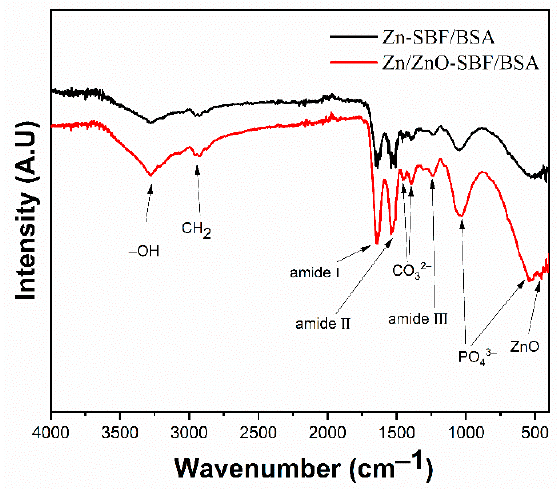
Figure 8. FTIR spectra of Zn and Zn/ZnO after 21 days immersion in SBF/BSA. Additionally, XPS was carried out for further insights on the chemical composition of the surface. Figure 9 depicts the XPS survey spectra for both bare Zn and Zn/ZnO samples in SBF/BSA after 21 days of immersion. Only signals of C, N, O, and P are present after immersion. The signals of Zn, Ca, and P were not detected after immersion in SBF/BSA. Considering the high surface sensitivity of XPS, it can be concluded that samples were covered with BSA after the immersion test. Figure 10 shows high-resolution XPS spectra of C, N, and O for both pure Zn and Zn/ZnO after immersion. The signal of C1s can be deconvoluted to C-H/C-C, C-N, C-O, C=O, and C=C-N [32,34]. The N1s spectrum was fitted to C-N and C=O-NH [35]. O1s spectra were deconvoluted to O 2 − , OH − , O=C-N, and H 2 O [36,37]; the presence of H 2 O and O 2 − is attributed to adsorbed water in the air and the formed ZnO, respectively. Table 3 shows atomic concentration from XPS spectra, indicating that more N is detected on the surface of Zn/ZnO as compared with bare Zn.